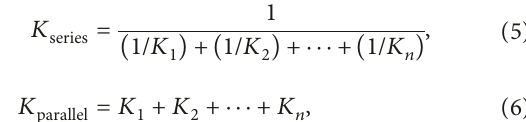
Figure 11: (a) Relationship between the strain variation of roof and floor after peak strength and the system stiffness ratio ( R Relationship between the strain energy densities of roof and floor after peak strength and the system stiffness ratio ( R K